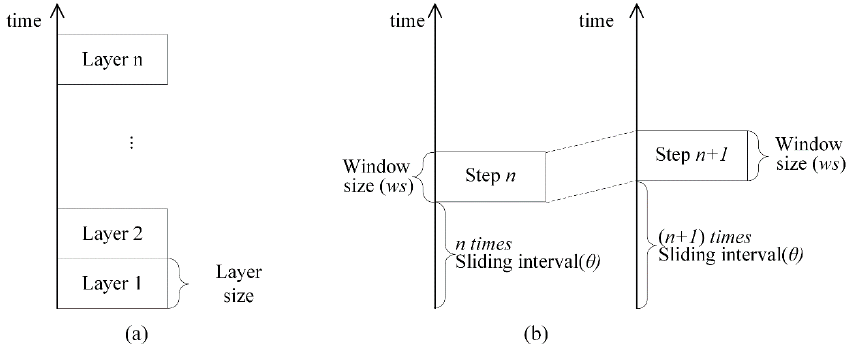
Figure 1. ( a ) Classical layer model. ( b ) Sliding window model.